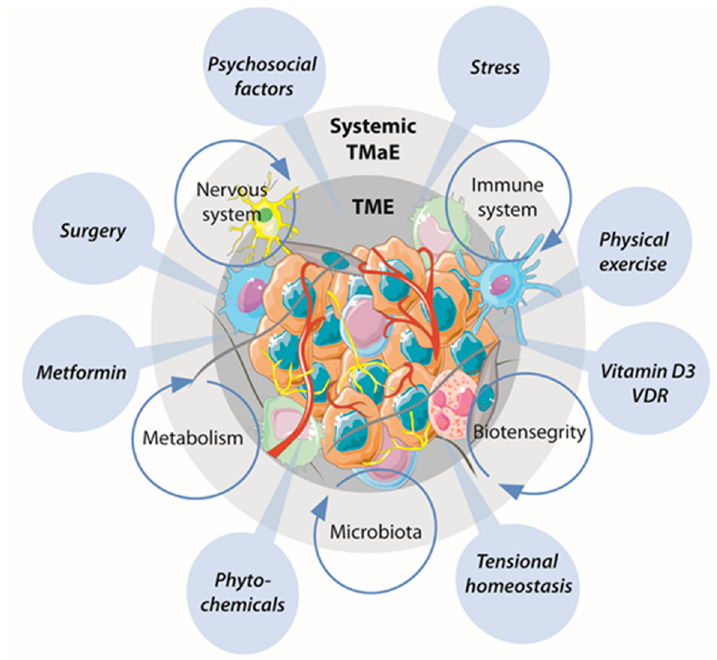
Figure 4. An integral vision of cancer biomarkers. TME elements are ultimately affected by systemic tumor macroenvironment (TMaE). The balance between them is a key determinant in tumor progression and aggressiveness. Therefore, analysis of this multi-level interaction could be beneficial for patient stratification and cancer therapy advancement and is also crucial for researchers in the field to improve current cancer models. Finally, emerging biomarkers need to be further explored and integrated to better understand the delicate information exchange occurring at the molecular/cellular/extracellular levels between the surrounding milieus. VDR: vitamin D3 receptor.